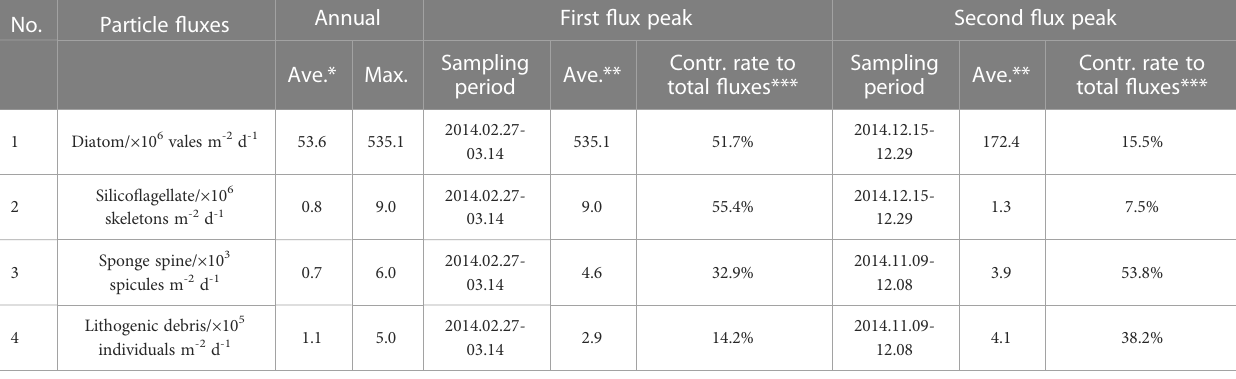
TABLE 2 Seasonal features of the fl uxes of siliceous microorganisms and lithogenic debris from the trap in Prydz Bay